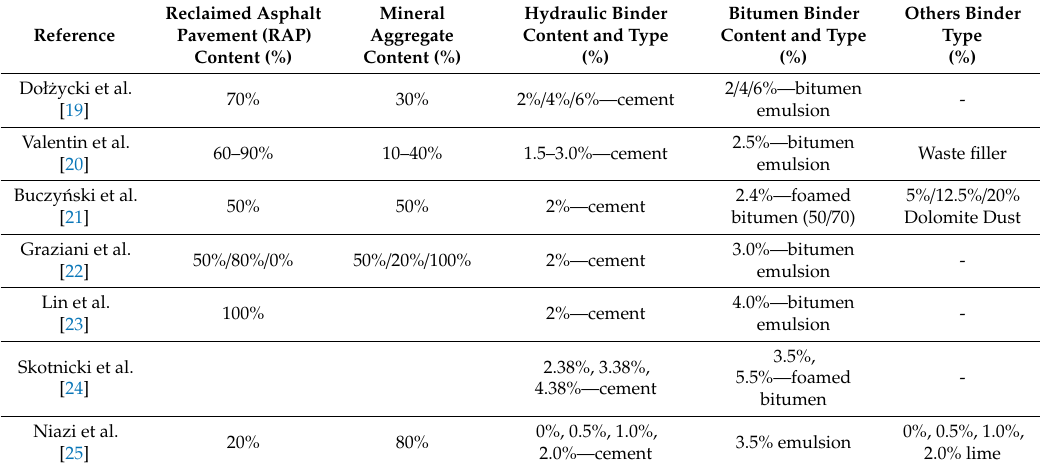
Table 1. Characteristics of base layer bound